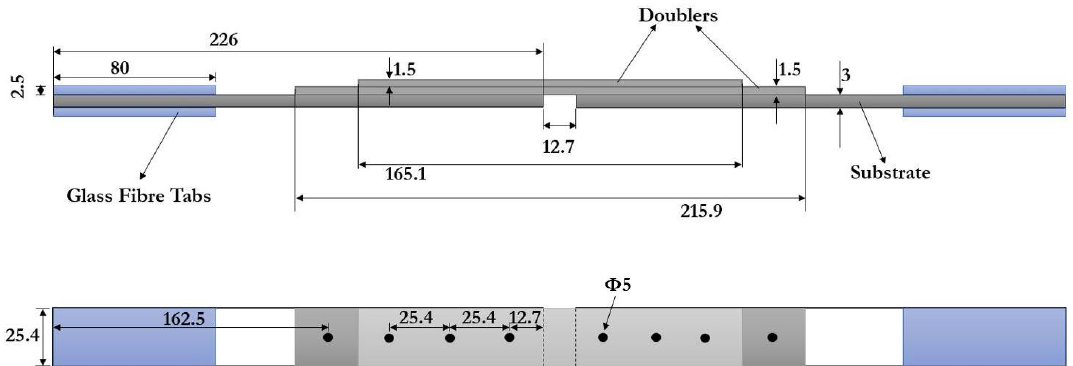
Figure 1. Dimensions of the studied double-lap joints (all units are in mm).